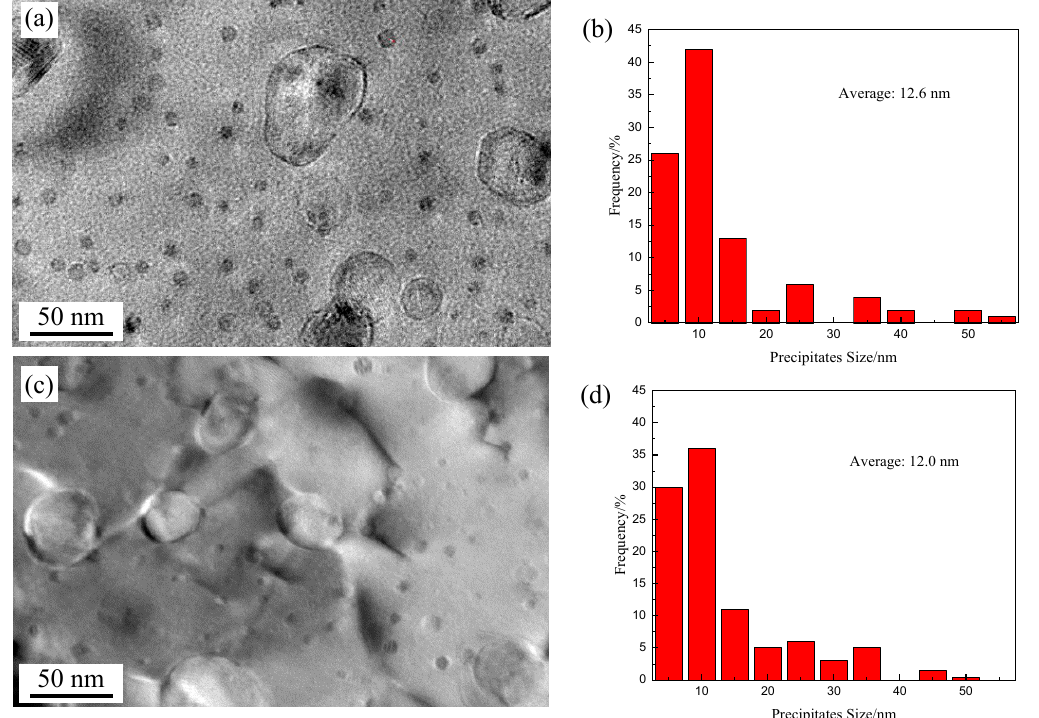
Figure 4. TEM images and diagram of nano-oxide particle size distribution of ( a , b ) HIP sample and ( c , d ) HIP + TMP sample.